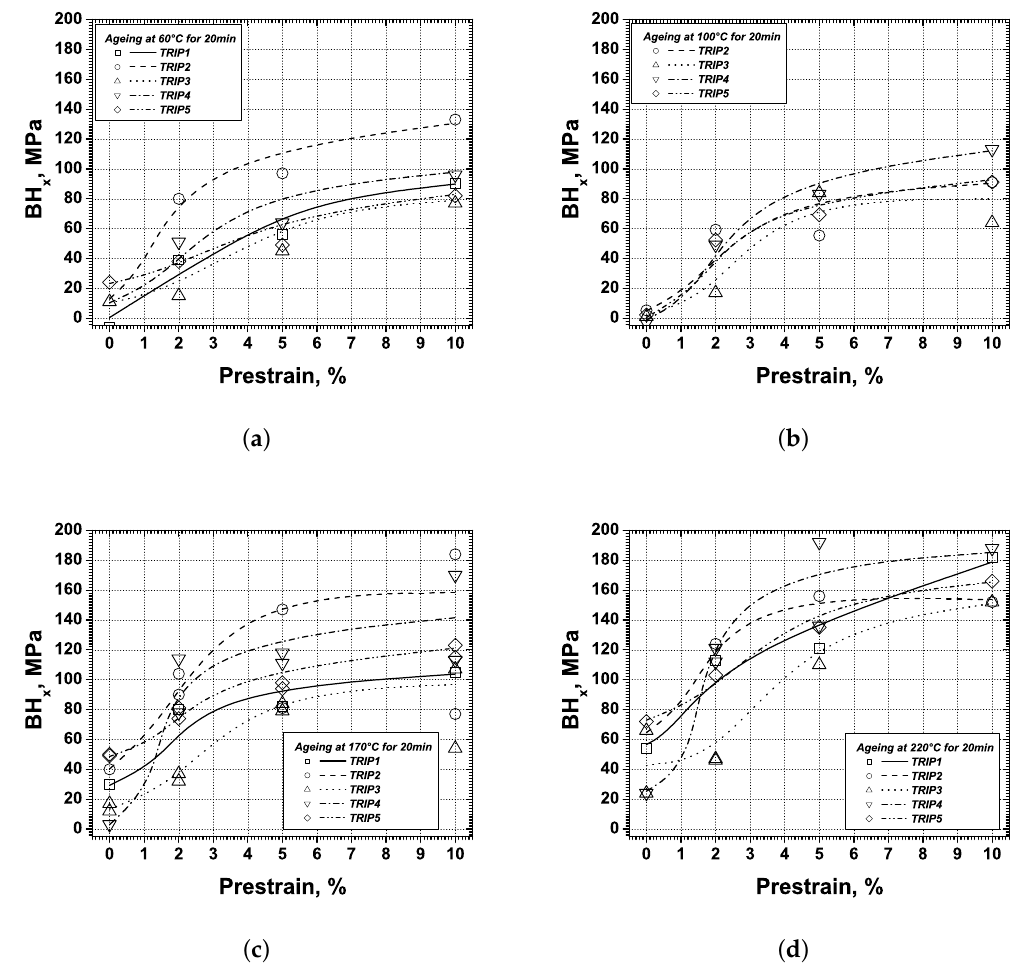
Figure 1. Bake-hardening values versus prestrain for the investigated TRIP1–TRIP5 steels for 20 min at different aging temperatures( a ) 60 ◦ C, ( b ) 100 ◦ C, ( c ) 170 ◦ C, ( d ) 220 ◦